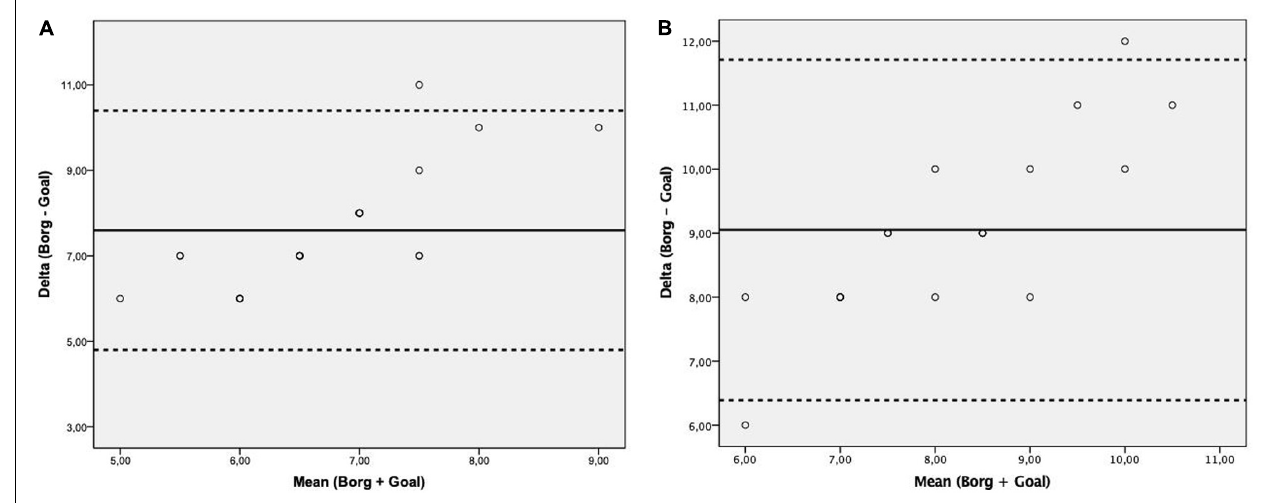
FIGURE 7 | Bland-Altman plot assessing the agreement between the Borg 6–20 scale and the Goal scale at ventilatory threshold (A) and respiratory compensation point (B) during cardiorespiratory test. Solid line represents the mean difference (bias) between Borg 6–20 and Goal scale. Upper and lower dashed lines represent the 95% limits of agreement (mean difference ± 1.96 × standard deviation of the